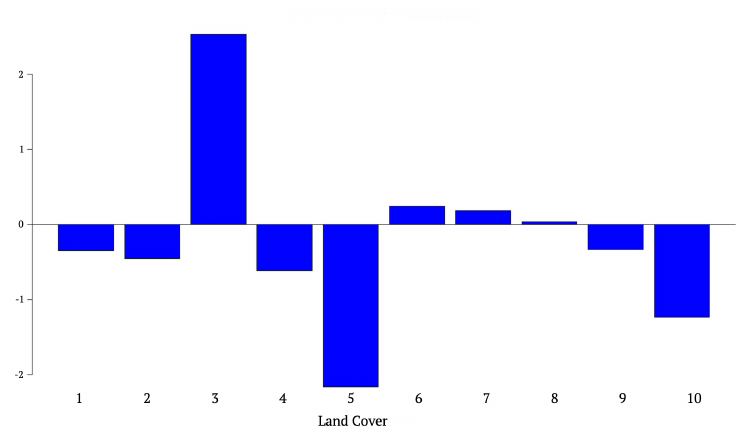
Figure 16. Partial dependence plots on the explanatory variable land cover. See Table 2 for class de- scriptions.